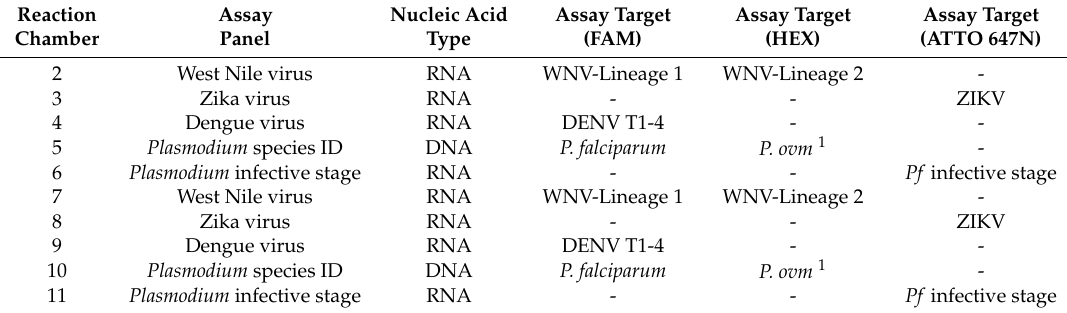
Table 2. VectorDisk assay panel for the NA Study. Targets are detected in 10 di ff erent reaction chambers and in three di ff erent detection channels (FAM-green, HEX-yellow, and ATTO 647N-red), detecting the fluorescence signal from the corresponding fluorophores in brackets. Reaction